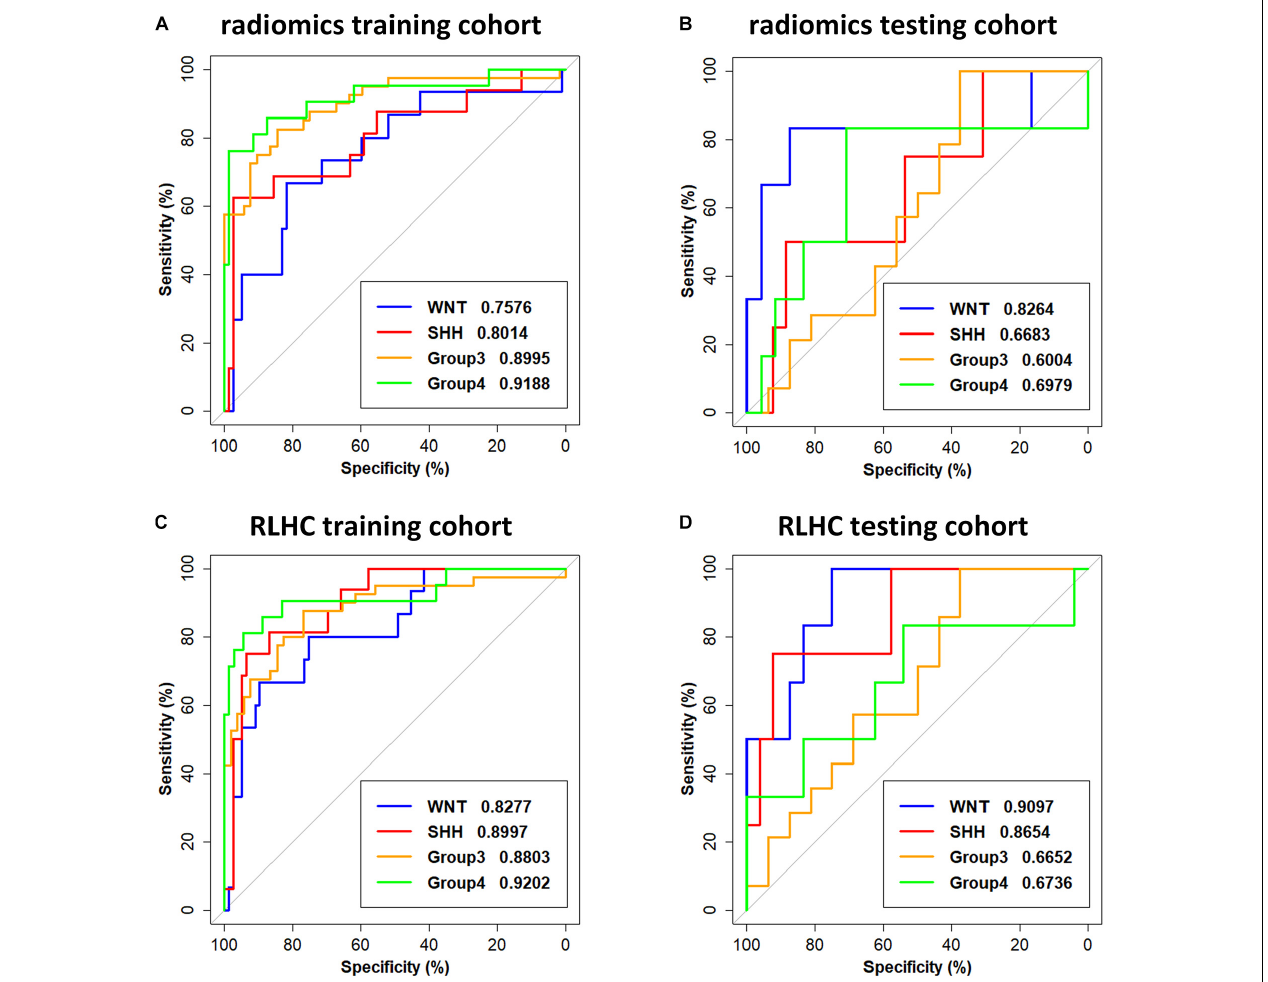
FIGURE 2 | Receiver operating characteristic (ROC) curves of the radiomics model and the radiomics, location, hydrocephalus, and clinical factors (RLHC) model. (A,B) ROC curves of the radiomics model on the training cohort and testing cohort, respectively. (C,D) ROC curves of the RLHC model on the training cohort and testing cohort,